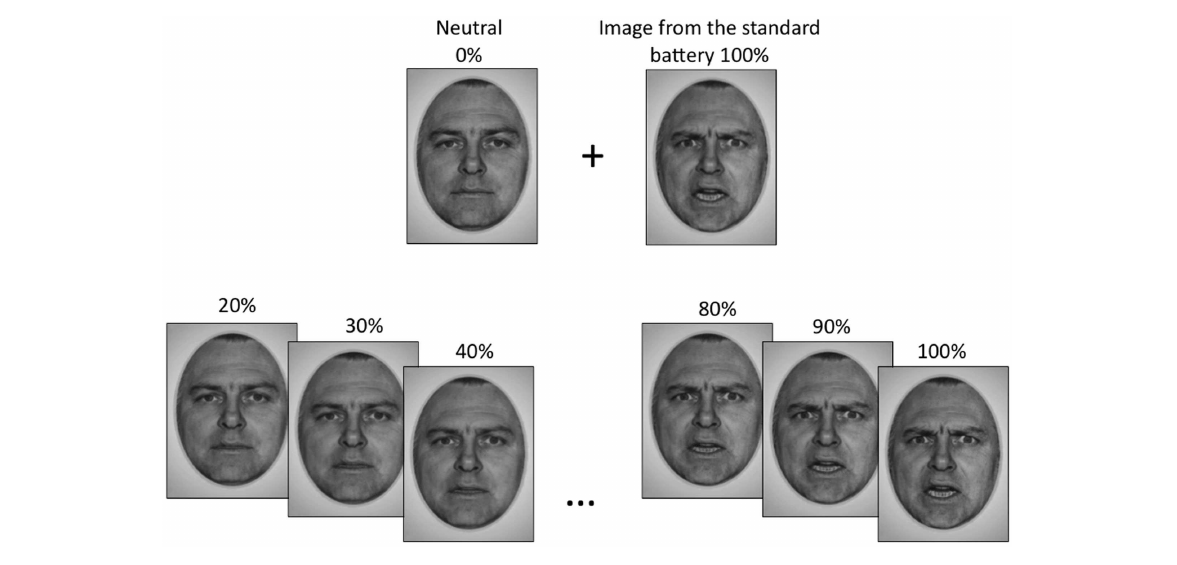
that emotion . Gradations began at 20% emotion content and increased in increments of 5% up to a maximum of 100%, which was the standard